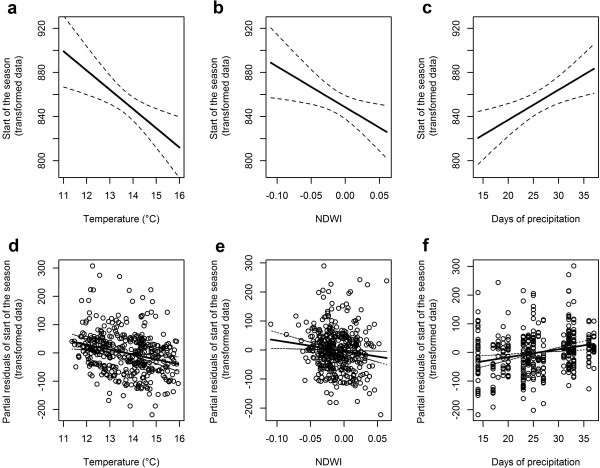
Association between the start of the mosquito season and environmental variables. Panels a-c show model predictions; panels d-f show partial residuals. The first column (a,d) shows the association between the start of the season and temperature (LST8–19), the second (b,e) shows the association with NDWI10–21 and the third (c,f) shows the association with precipitation (DAY_PREC6–17). Note that all plots show transformed data on the y axis (i.e. x1.3); back transformed values are presented in the text to assist interpretation.